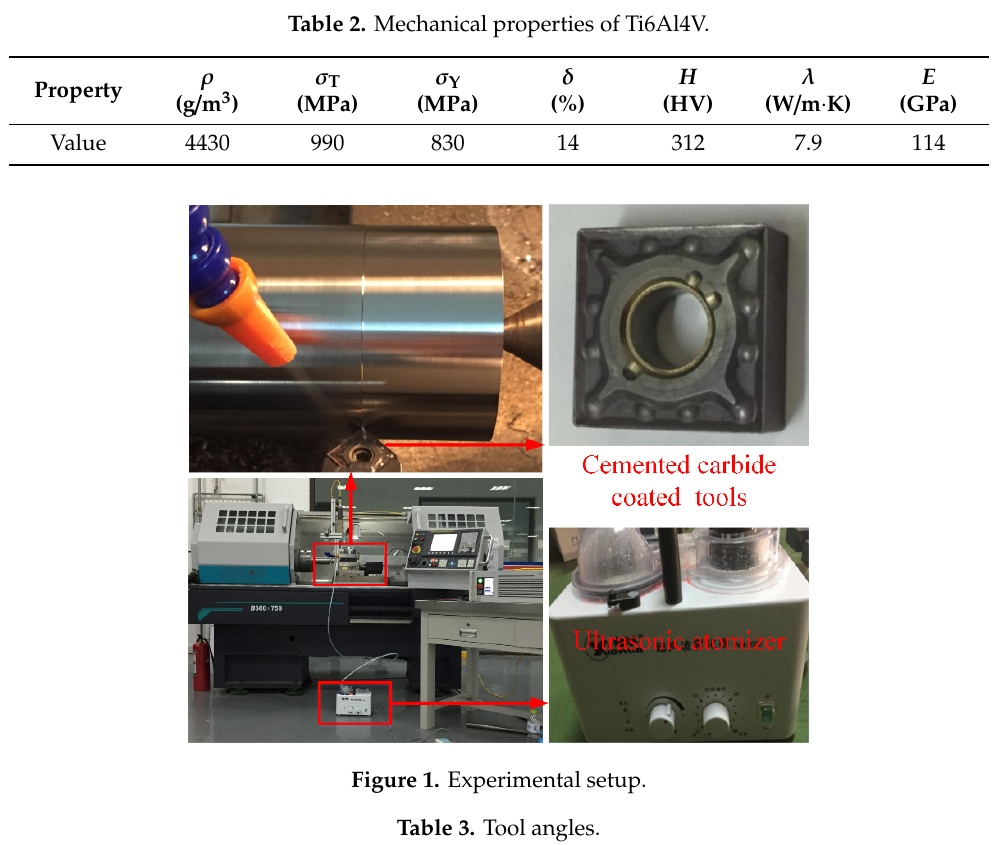
Table 3. Tool angles.